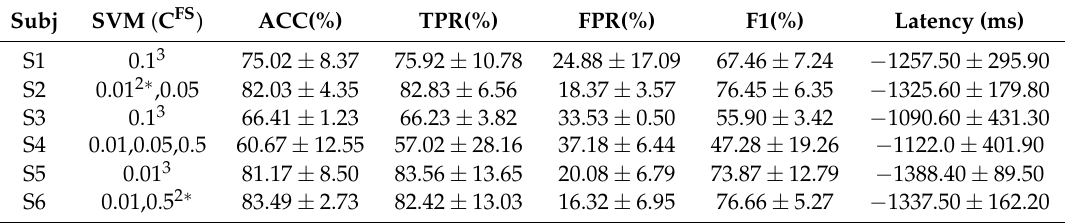
Table 2. Performance of the BCI based on Ad LAR to recognize gait